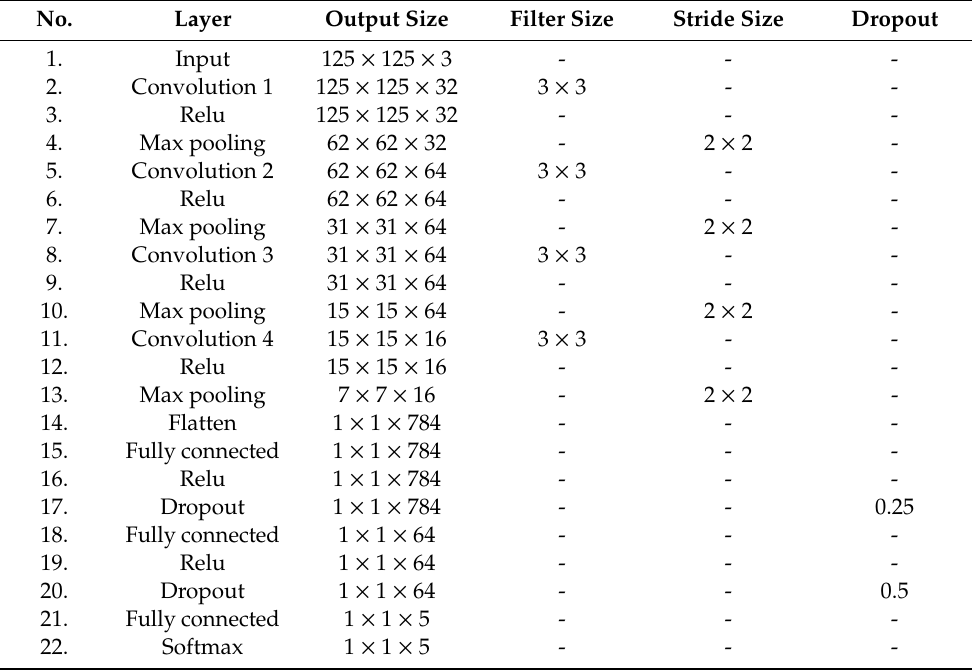
Table 1. Detailed parameters of the designed